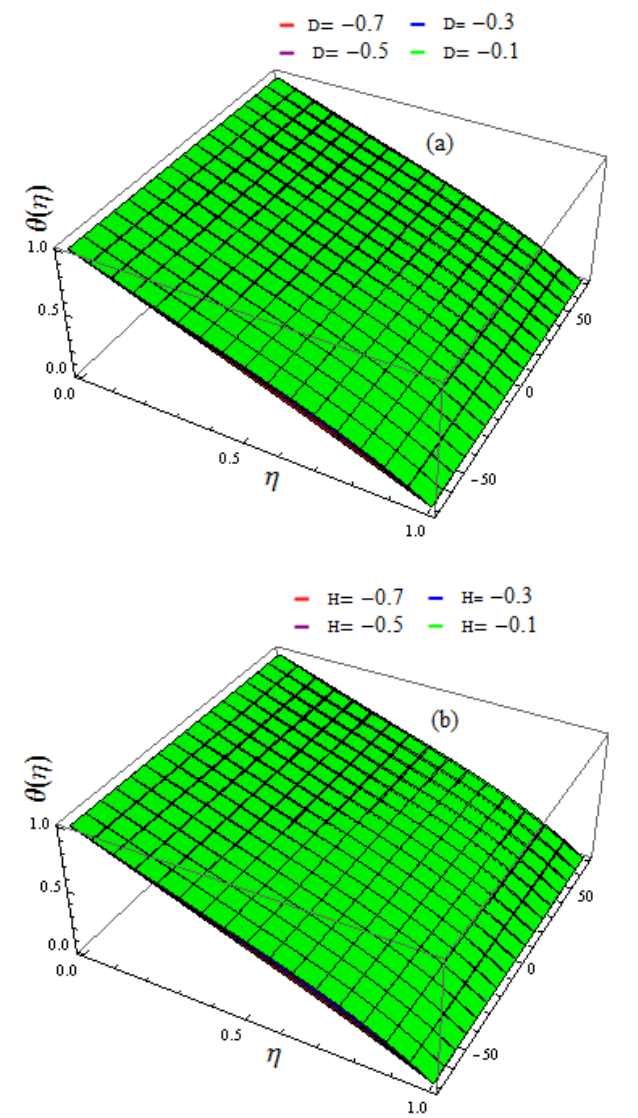
Figure 15. ( a ) Influence of D < 0. ( b ) H < 0 on θ ( η ) Figure 15. ( a ). Influence of 𝐷 < 0 ( b ) 𝐻 < 0 on 𝜃(𝜂) .